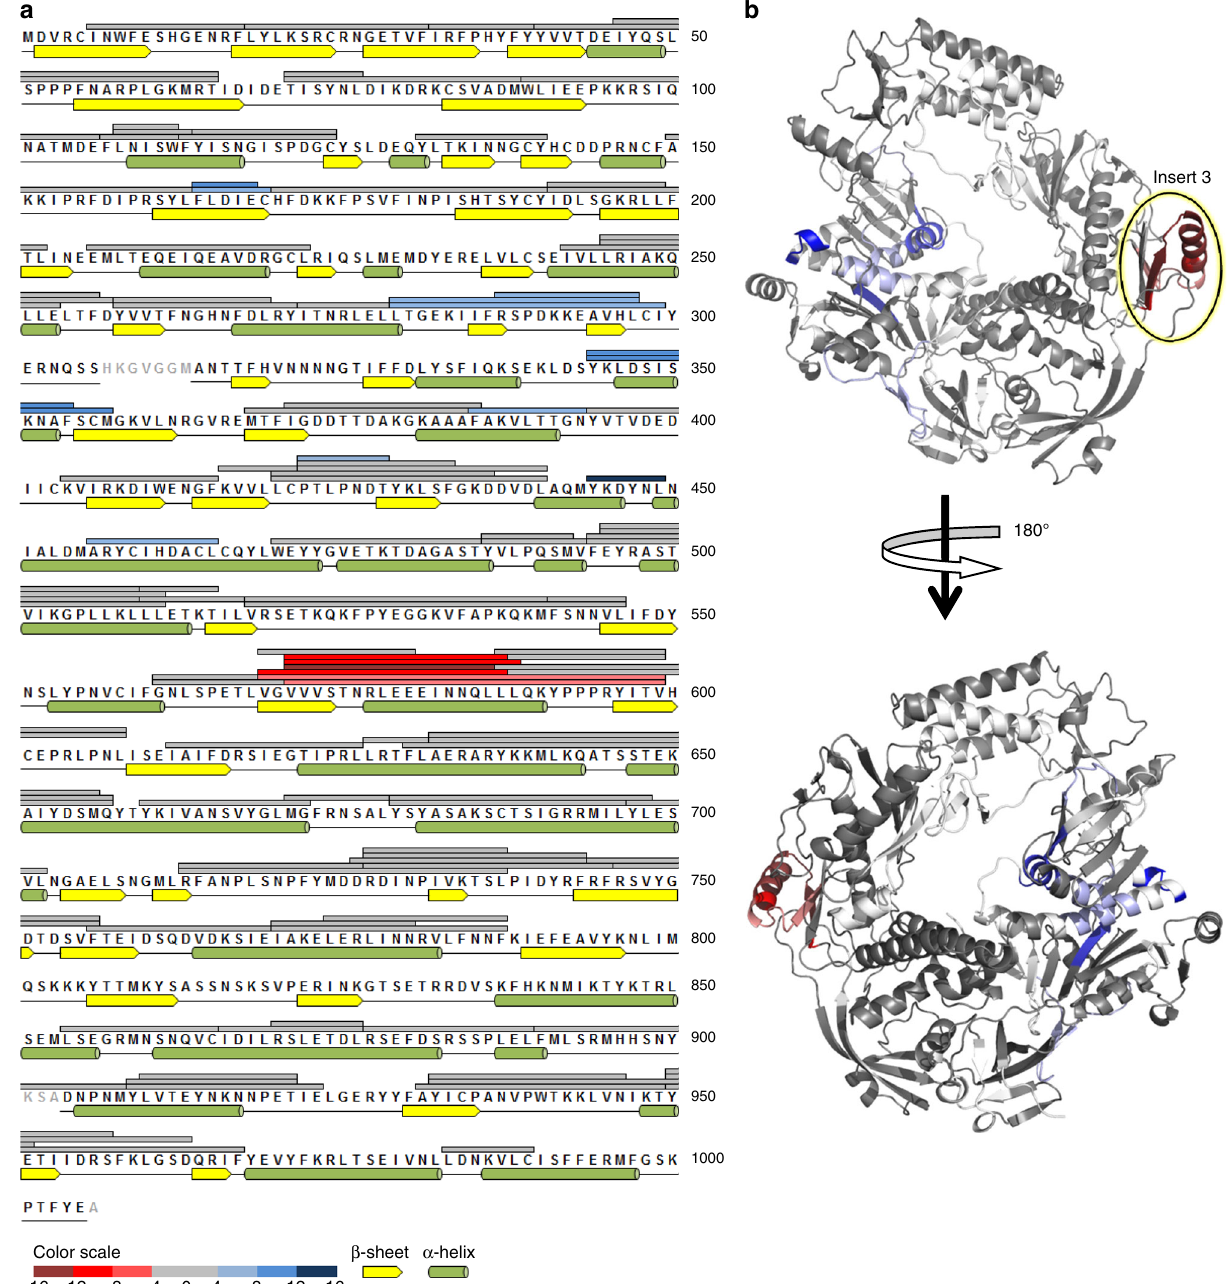
Fig. 3 Peptides protected by the E9 A20 C-ter interaction determined by H/D exchange MS. a Peptides from E9, identi fi ed by LC-MS/MS, are represented as bars above the primary sequence. The secondary structure, derived from the crystal structure, is shown underneath the sequence (in gray residues not seen in the structure). The level of protection of individual peptides, as determined by comparing the % D incorporation for free E9 with the one for E9 bound to A20 C-ter, is color coded according to the scale bar. Highly protected areas are shown in red, whereas peptides becoming more exposed upon complex formation are shown in blue. The highly protected region involves the α -helix of insert 3 (residues 577 – 590). b H/D exchange results are mapped onto the crystal structure of E9. Protected residues are color coded as in